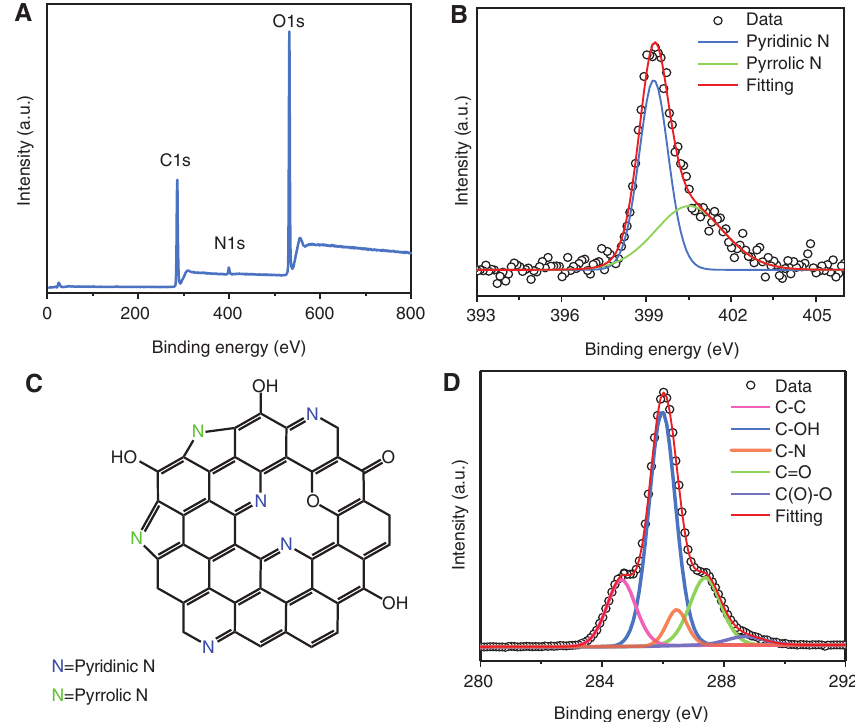
Figure 4: (A) Full-scan XPS spectrum of NGQDs. (B) High-resolution N 1s spectra of NGQDs. (C) Schematic of pyridinic (blue) and pyrrolic (green) N atoms. (D) High-resolution C 1s spectra of